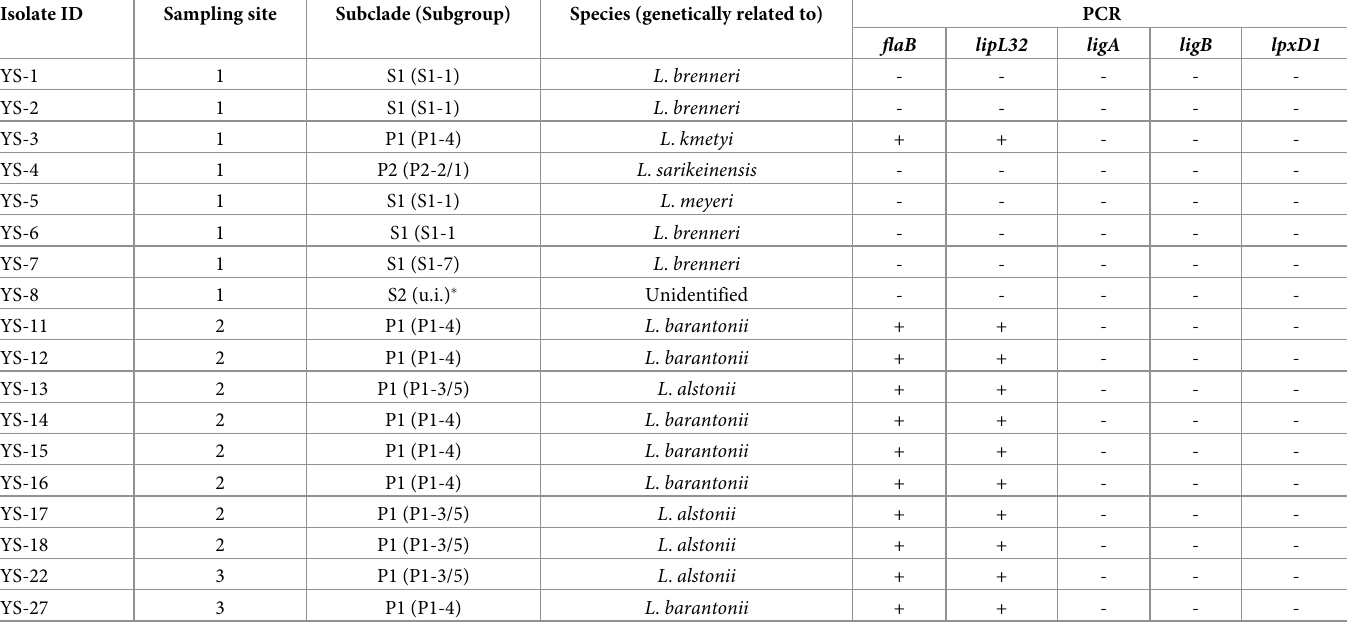
Table 3. Characterization of environmental Leptospira isolates. Isolate ID Sampling